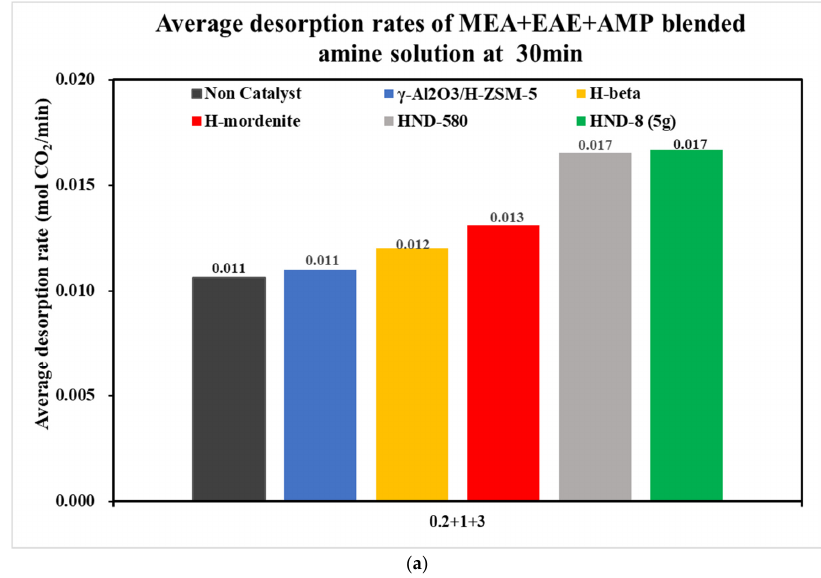
Figure 10. The CO 2 desorption profiles of MEA + EAE + AMP at 0.2 + 1 + 3 mol/L with catalysts.